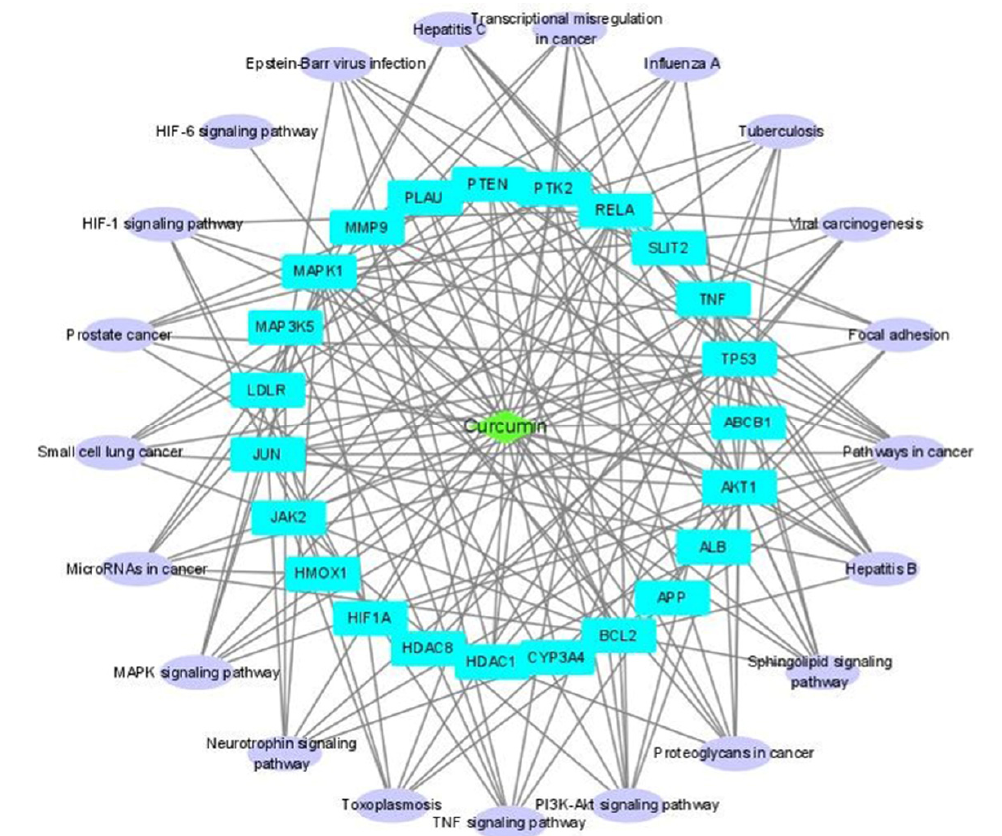
Figure 4. Compound–disease target–pathway (C-D-P) network. C-D network and D-P network were constructed and merged to produce the C-D-P network using Cytoscape.